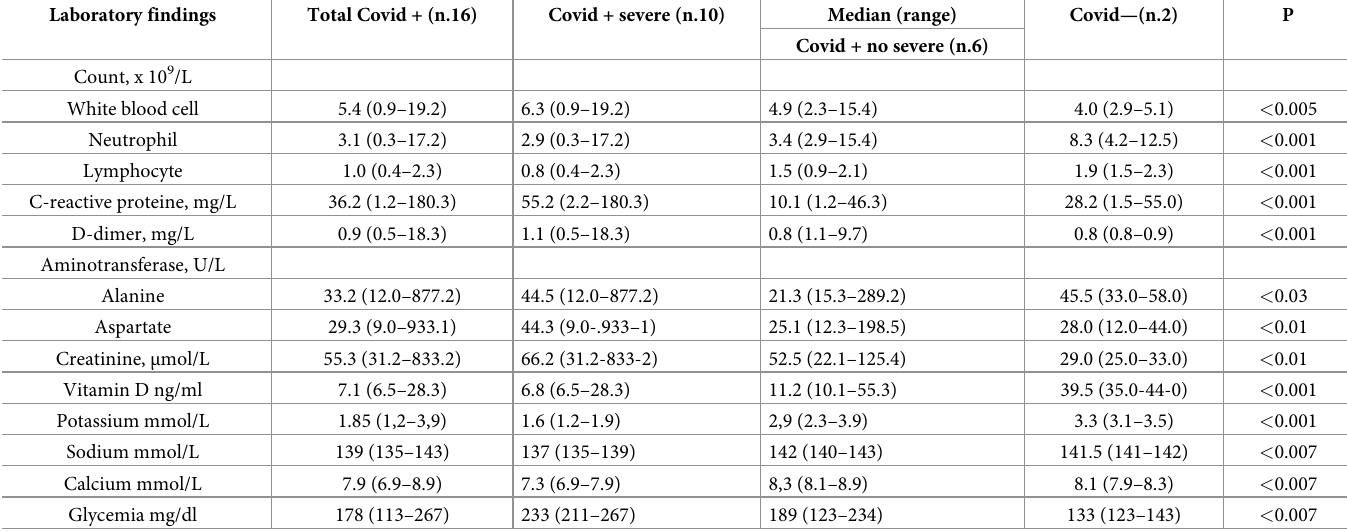
Table 2. Laboratory findings of DOC COVID-19 and not